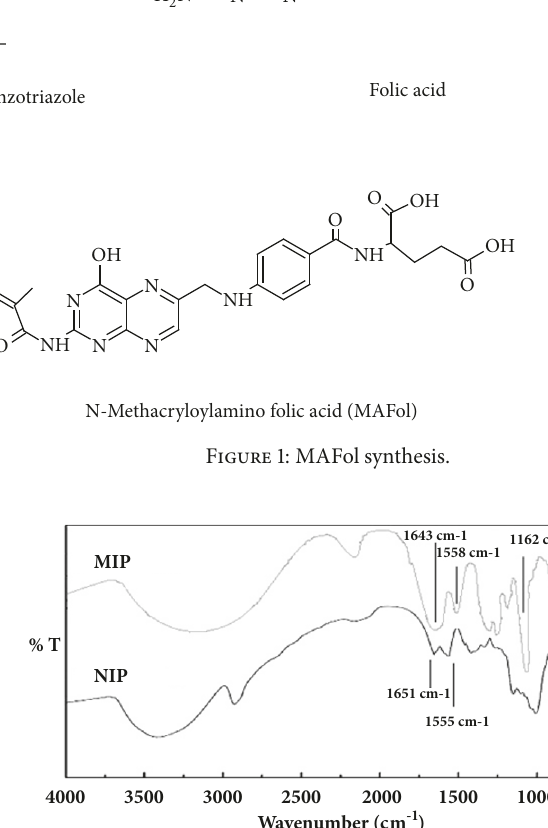
Figure 2: FT-IR spectra of imprinted microspheres (MIP) and nonimprinted microspheres